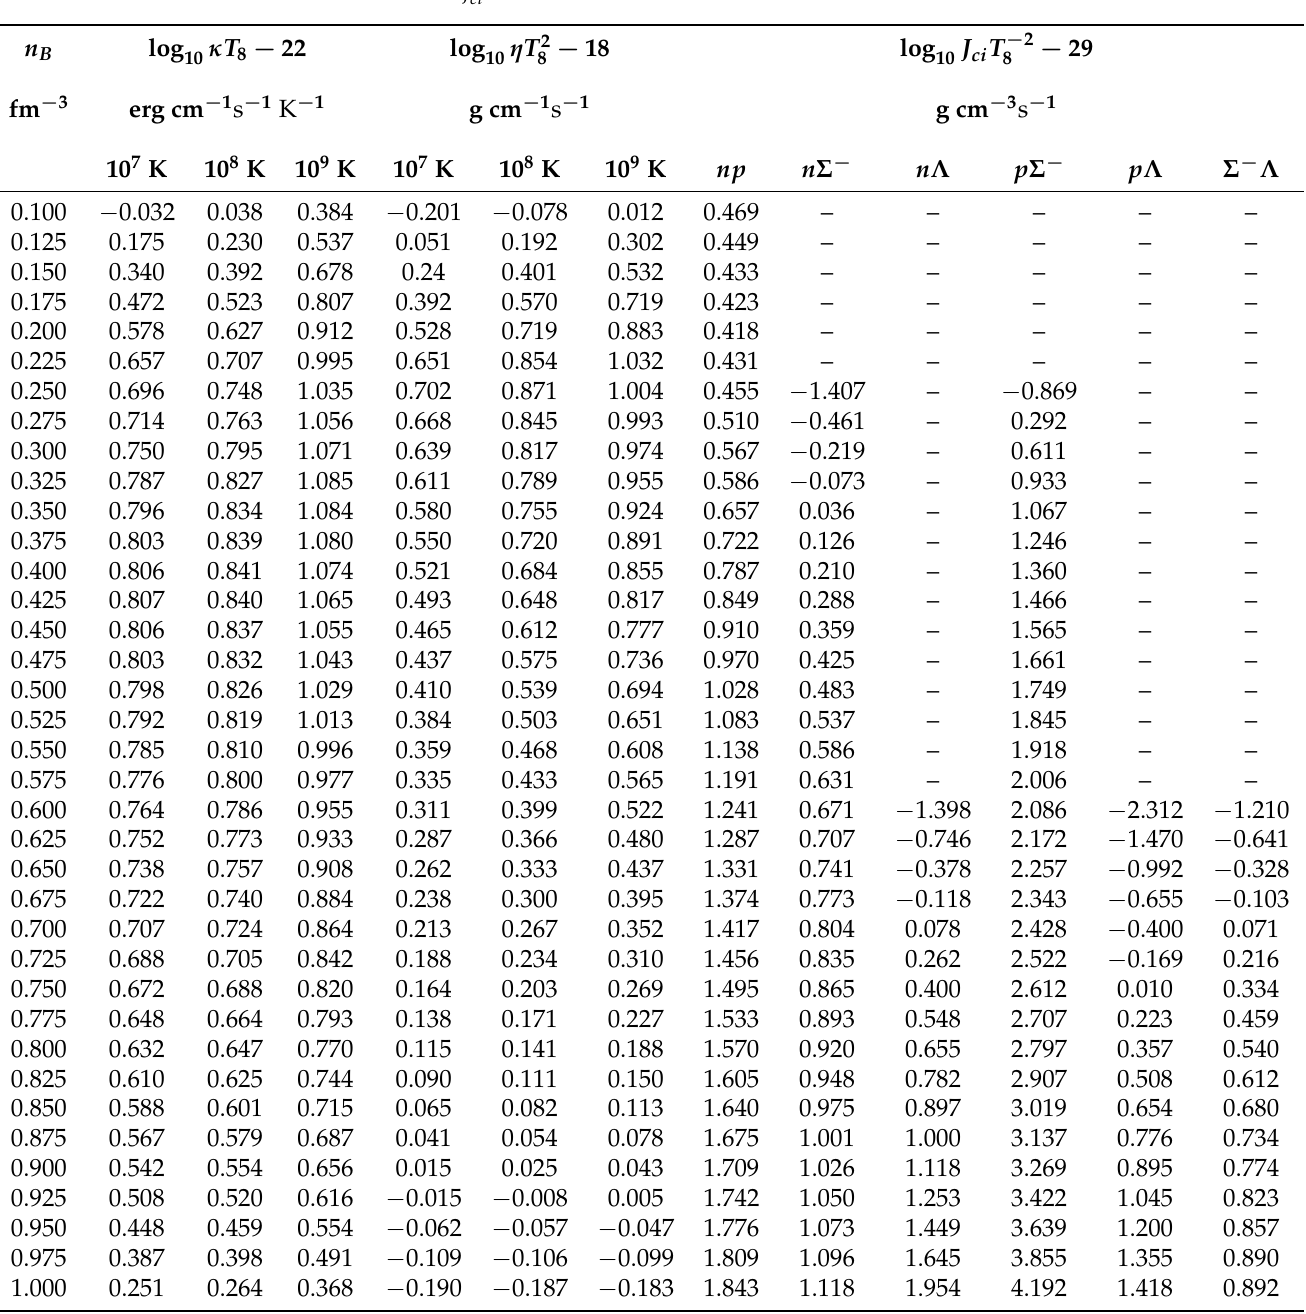
Table A3. Transport coefficients of the hypernuclear matter as a function of baryon density for the NSC97e model. Columns 2 – 4 : total thermal conductivity for three values of temperature. Columns 5 – 7 : total shear viscosity for three values of temperature. For η and κ exact solutions of transport equations in the sense described in the text are shown. Columns 8 – 14 : momentum transfer rates J ci